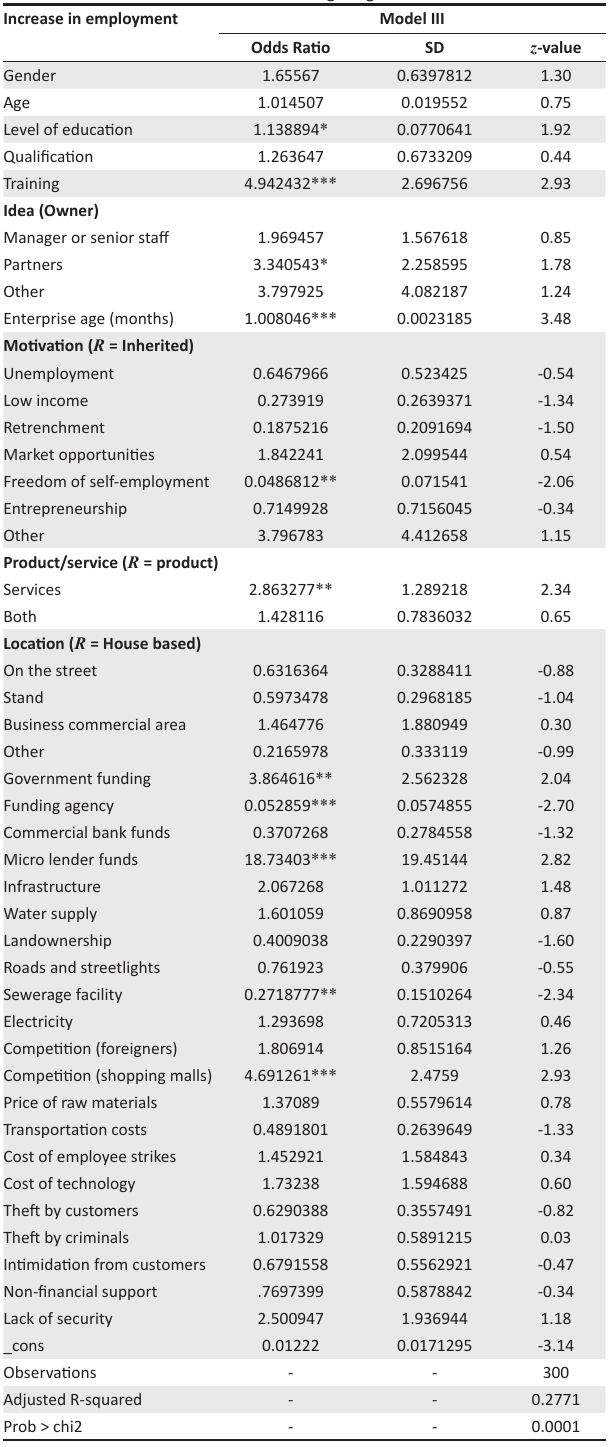
TABLE 7: Relationship between enterprise growth, manager and enterprise characteristics and external constraints: Logit regression